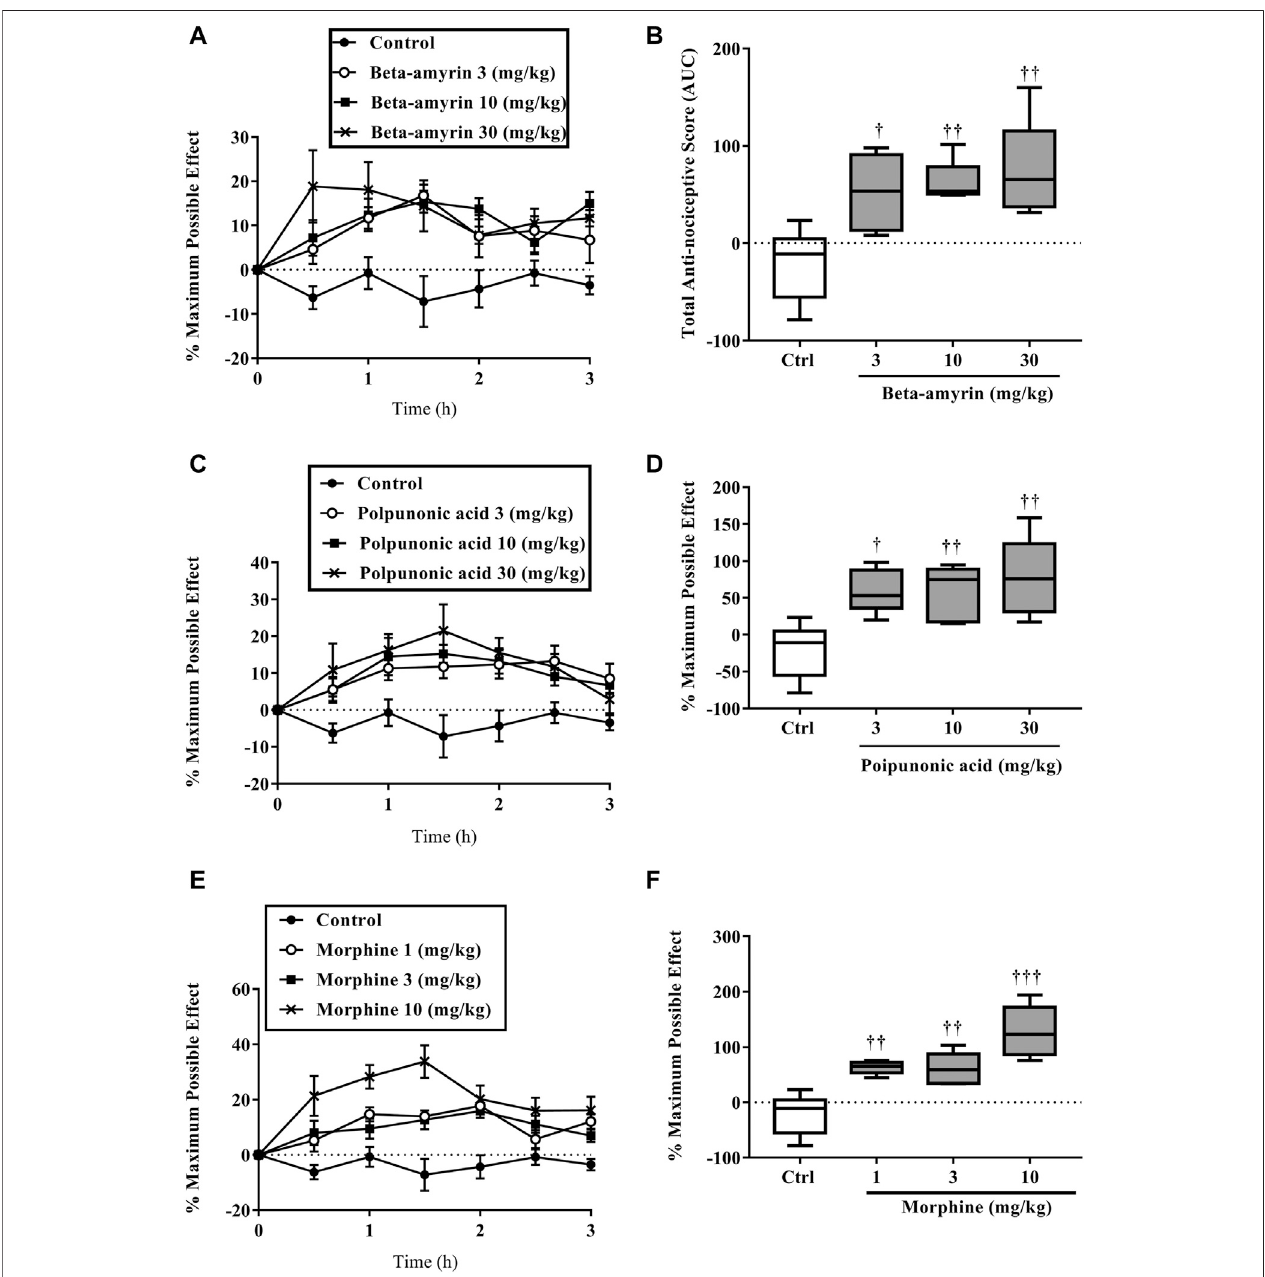
FIGURE 10 | The percentage maximum possible effect (A, C, D) and total antinociceptive effect (B, D, E) of β -amyrin (3, 10 and 30 mg/kg, p. o.), polpunonic acid (3, 10 and 30 mg/kg, p. o) and morphine (1, 3 and 10 mg/kg, p. o) presented as the area under the curve (AUC) in tail-immersion test in mice. The symbols * p < 0.05; ** p < 0.01; *** p < 0.001 denote signi fi cant differences in time-course curves of treatment compared to the control (Ctrl) group (two-way ANOVA followed by Dunnet ’ s multiple comparison test) whereas † p < 0.05, †† p < 0.01, ††† p < 0.001 denote signi fi cant differences of treatment in comparison with control (Ctrl) group using the one-way ANOVA followed by Tukey ’ s multiple comparison